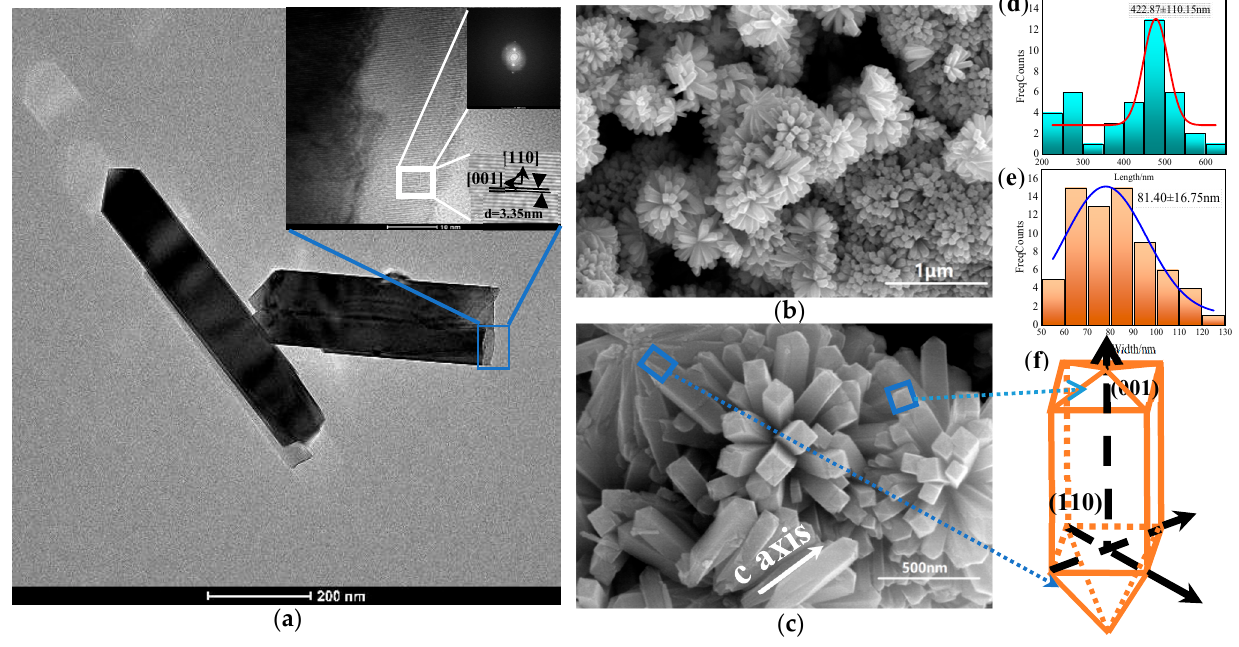
Figure 6. TEM and FESEM images of SnO 2 (NR): ( a ) low-magnification TEM image of single SnO 2 (NR), (inset) calibration of Fourier transform mode and interplanar crystal spacing; ( b ) 1 μ m FESEM image; ( c ) 500 nm FESEM image. Frequency statistics charts of ( d ) nanorod length and ( e ) nanorod width. ( f ) Growth model of synthesised SnO 2 nanorods with thermodynamic stability.